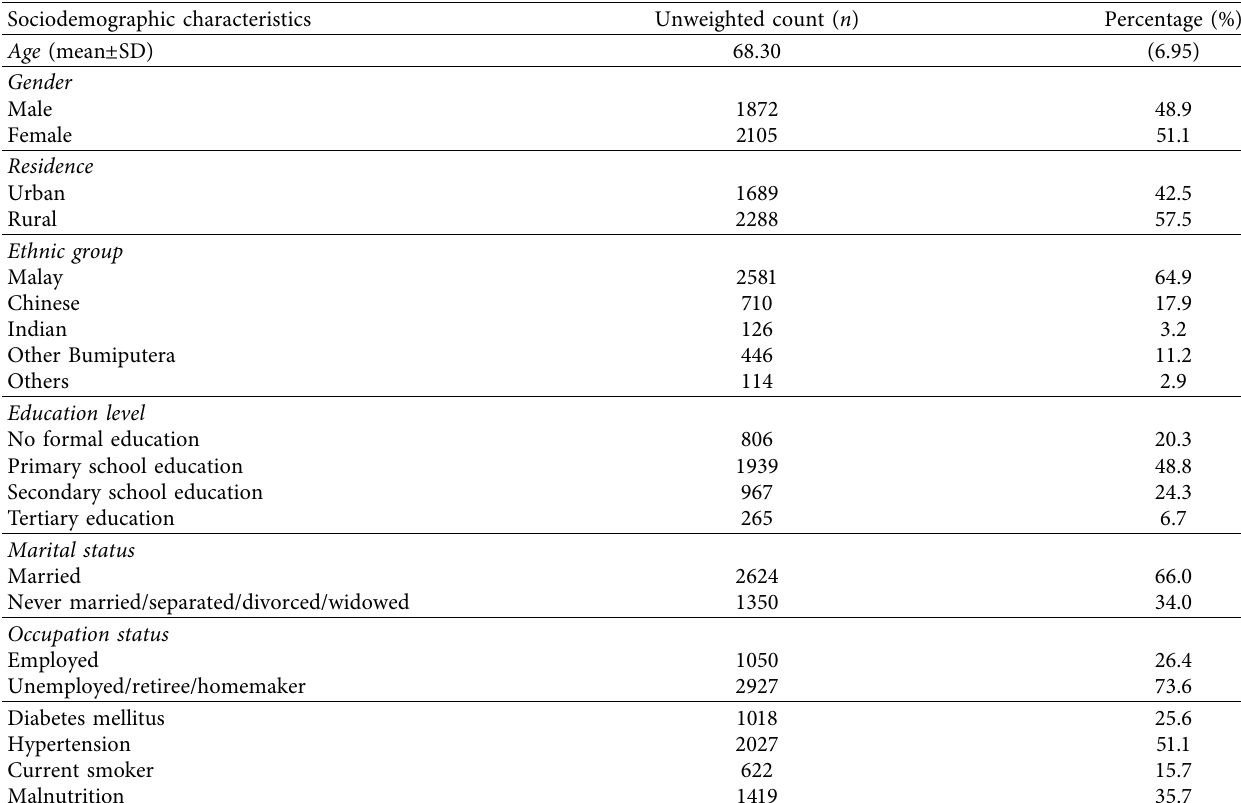
Table 2: Sociodemographic characteristics of the elderly (60 years and above), NHMS 2018 ( n � 3977). Sociodemographic characteristics